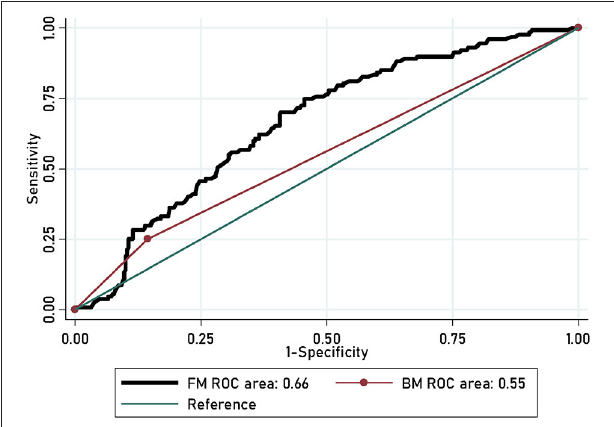
FIGURE 5 | ROC plots of risk factor for SA in MDD patients.